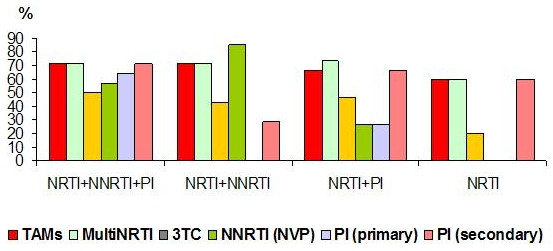
Presence of drug-specific HIV-1 mutations in relation to ARV regimens.